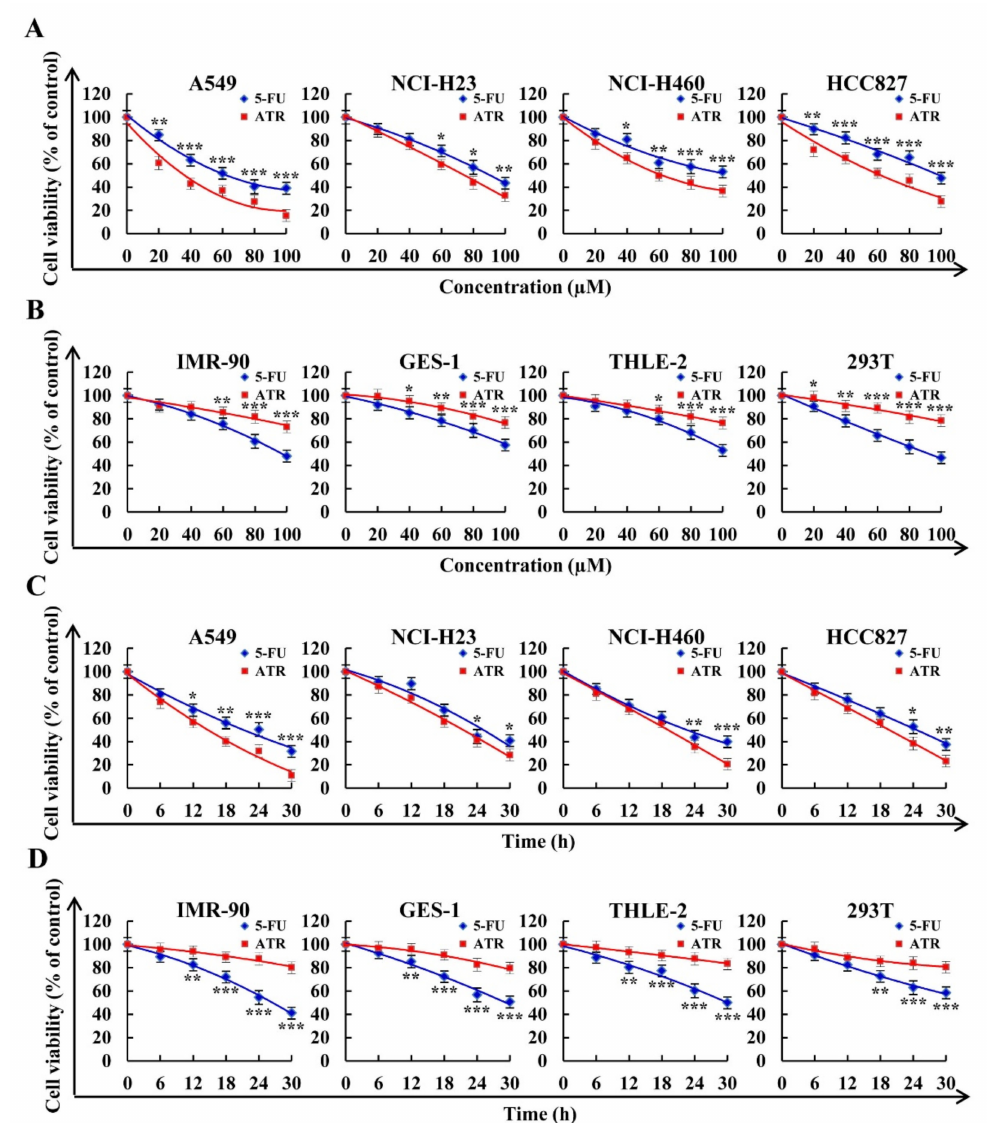
Figure 1. Cytotoxic effects of 5-FU and ATR on cells. Cells treated with different doses of fluorouracil (5-FU) and ATR (20, 40, 60, 80, and 100 µ M) for 24 h, and cell viability was detected by CCK-8 assay. ( A ) Viability of human lung cancer cell lines (A549, NCI-H23, NCI-H460, and HCC827). ( B ) Viability of human normal cell lines (IMR-90, GES-1, THLE-2, and 293T). Cells treated with 5-FU and ATR for 6, 12, 18, 24, and 30 h, and cell viability was detected by CCK-8 assay. ( C ) Viability of human lung cancer cell lines (A549, NCI-H23, NCI-H460, and HCC827). ( D ) Viability of human normal cell lines (IMR-90, GES-1, THLE-2, and 293T). * p < 0.05, ** p < 0.01 and *** p < 0.001 vs. 5-FU